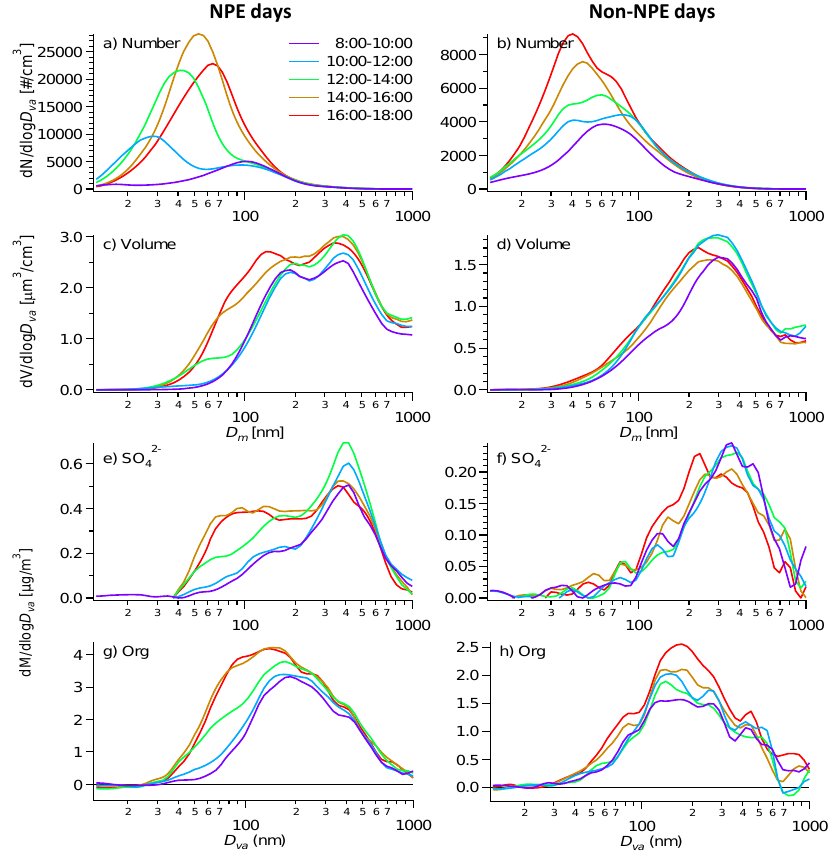
Figure 9. 2h averaged size distributions of (a, b) particle number and (c, d) volume, (e, f) SO 2 − and non-NPE days (right panel) between 08:00 and 18:00PDT at